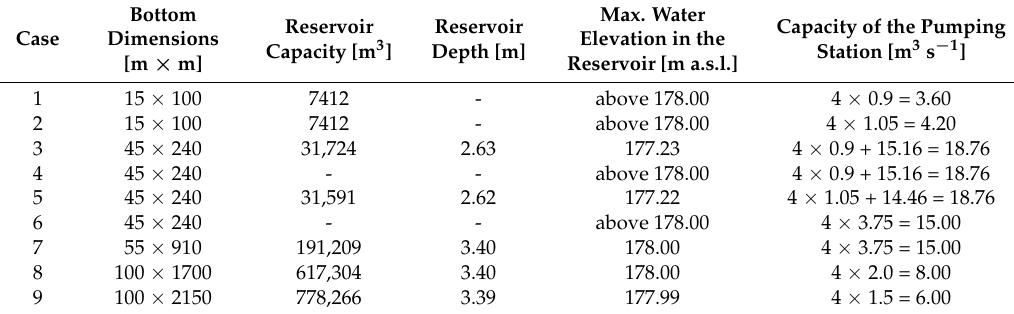
Table 3. Results of wave transformation calculations with regards to the assumed design